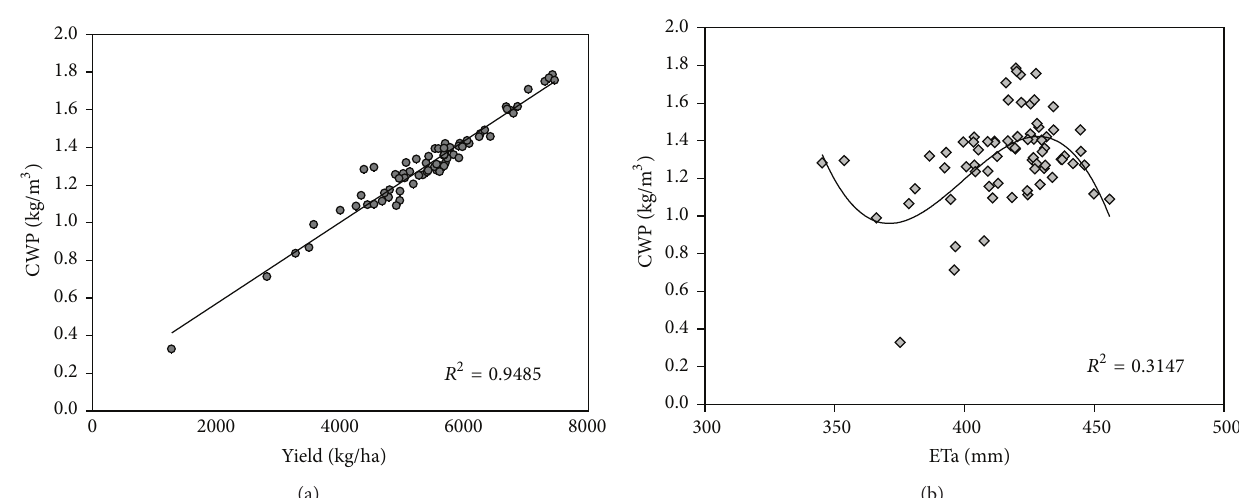
Figure 7: The relationship between yield and CWP (a) and the relationship between ETa and CWP